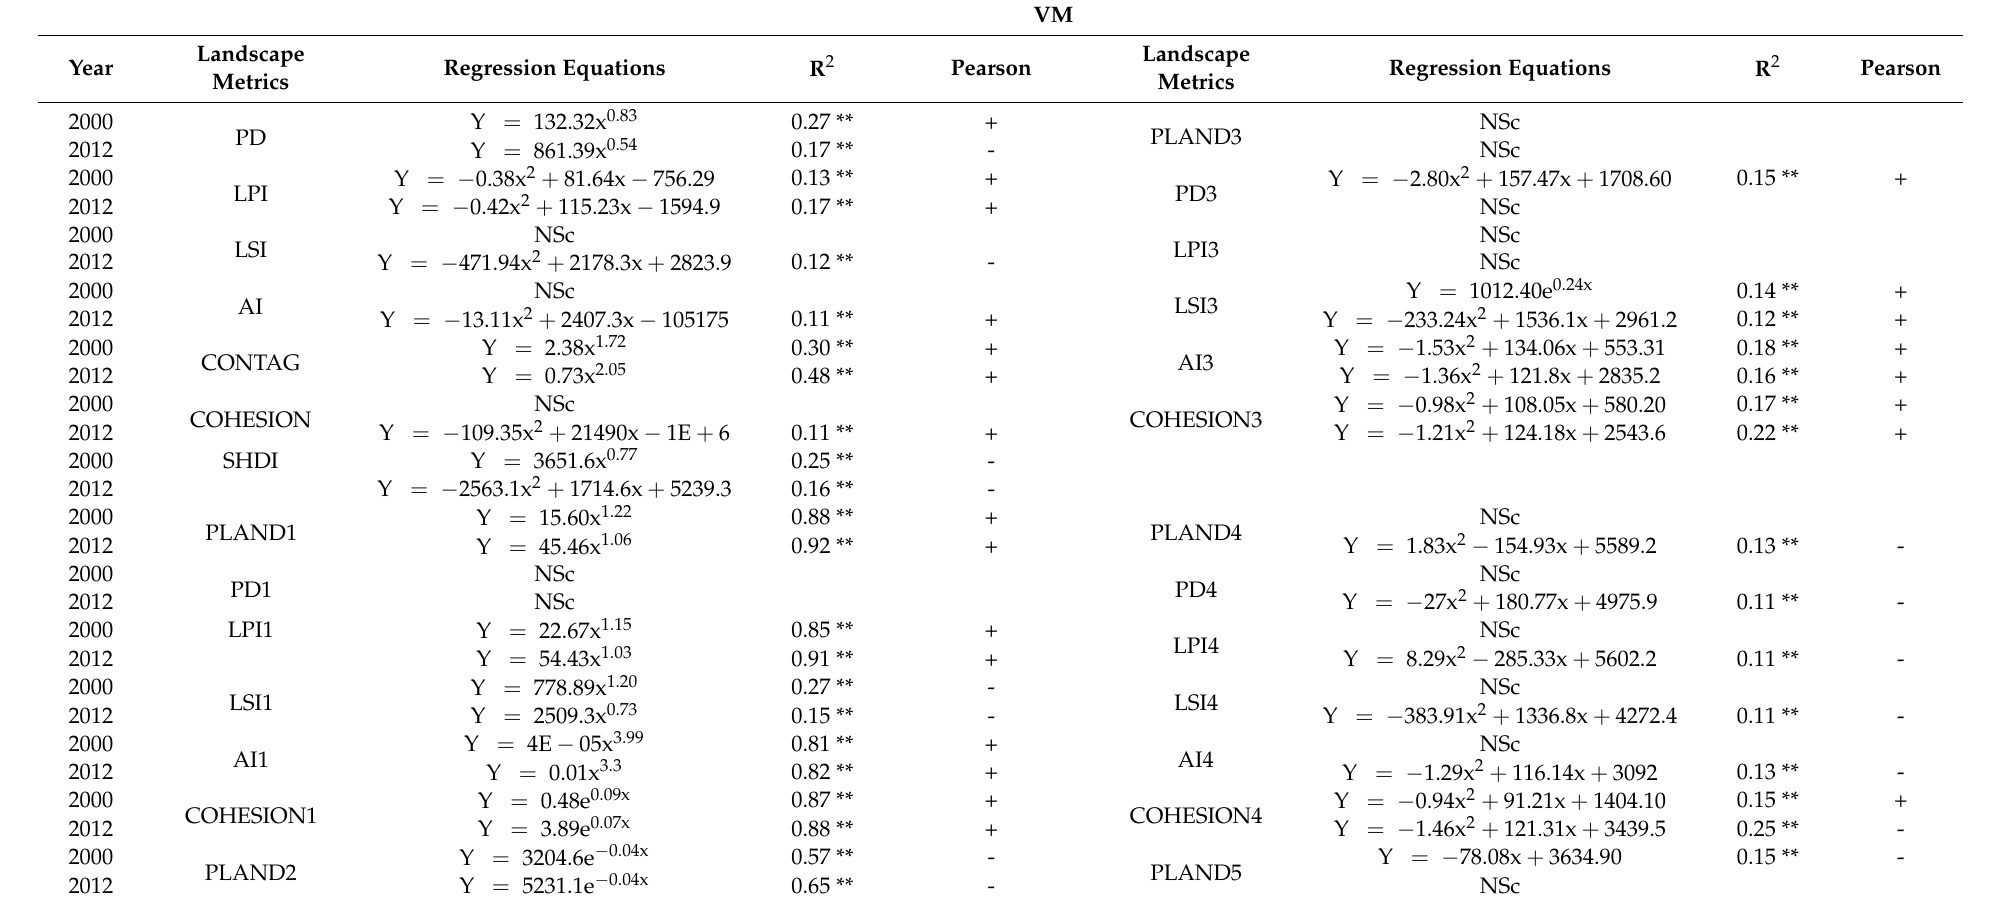
Table A1. Regression equations between landscape metrics and